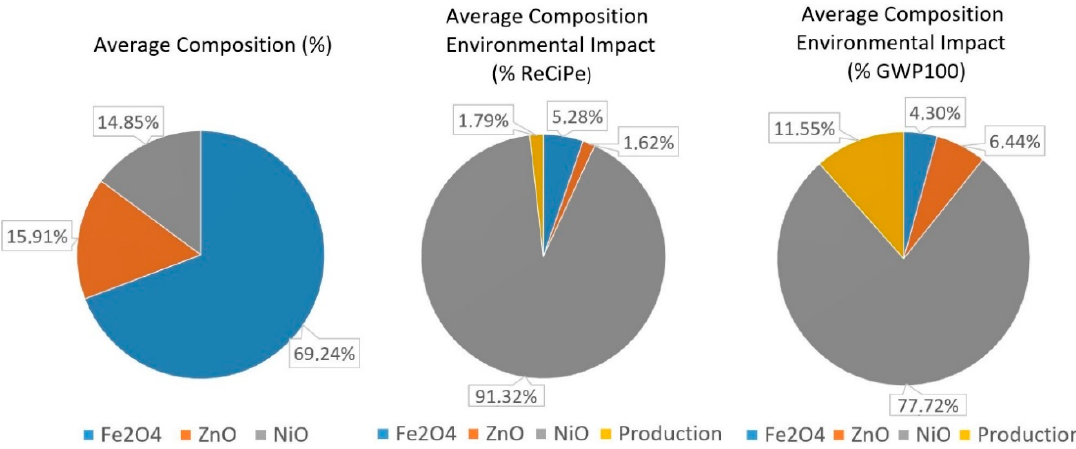
Figure 9. NiZn soft ferrite with average composition environmental impact in the ReCiPe and Carbon Footprint methodologies.